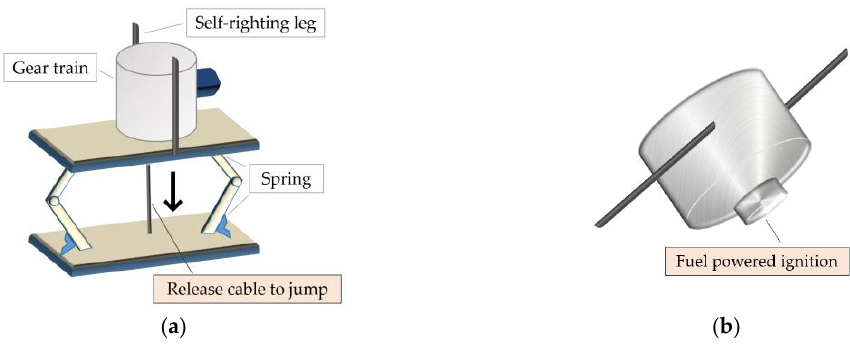
Figure 1. Examples for robots based on hopping: ( a ) MSU [11]; ( b ) DARPA [12,13].